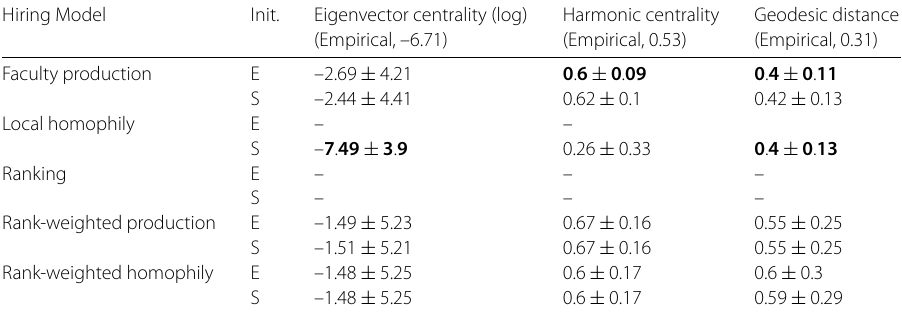
Table 1 Mean value of network summary statistics for five hiring models vs. the empirical values for Business. Mean values of the three network summary statistics—eigenvector centrality, harmonic centrality, and normalized mean geodesic distance—for networks produced by each of the five hiring models vs. the corresponding values of the empirical Business network. Boldface values are close to the empirical value. Uncertainty indicates the average absolute distance between predicted and empirical value. For this comparison, parameter combinations achieving the closest structural inequality are applied when β = 1.0 (Table S2). Two initializations (Init.) of Egalitarian (E) and Skewed (S) are used. Dashed line represents the Ranking and Local homophily model are unable to reproduce realistic structural inequalities. All values are rounded to the second digit Hiring Model Init. Eigenvector centrality (log) Harmonic centrality Geodesic distance (Empirical, –6.71) (Empirical, 0.53) (Empirical, 0.31) –2.69 ±